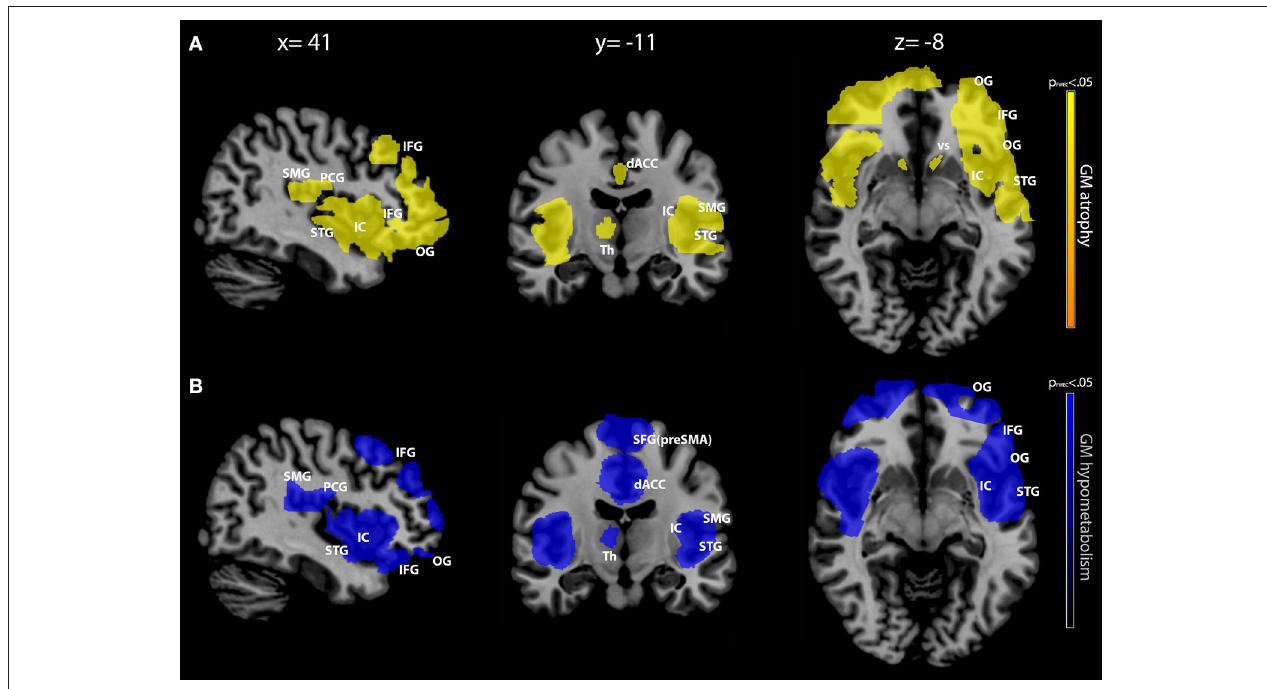
FIGURE 1 | Between-group comparison (patients vs. controls) of gray matter (GM) density and metabolism. GM density [in yellow , row (A) ] and metabolism [in blue , row (B) ] modifications in patients with behavioral variant frontotemporal dementia (bvFTD) compared with cognitively unimpaired controls. Between-group comparisons were conducted separately for each imaging modality with two-sample t -test routine. Only clusters surviving a p < 0.05 (family-wise error corrected with a minimum cluster size of 160) are shown, as indicated in the color bars representing p -values on the left . Maps are reported in accordance with radiological convention (i.e., left is right). MNI coordinates are on top of the panel . OG, orbital gyri; IFG, inferior frontal gyrus; SMG, supramarginal gyrus; PCG, pre-central gyrus; STG, superior temporal gyrus; IC, insular cortex; dACC, dorsal anterior cingulate cortex; SFG (pre-SMA), superior frontal gyrus (pre-supplementary motor area); VS, ventral striatum; Th, thalamus; MNI, Montreal Neurological